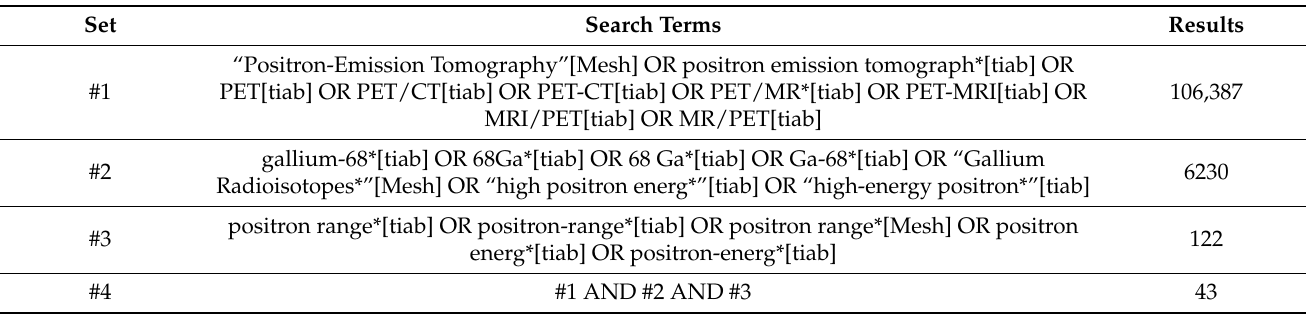
Table A1. The search query for positron range correction techniques in PubMed. In the column “Results”, the numbers of records are provided for the corresponding search terms from January 2010 until 1 August 2022.